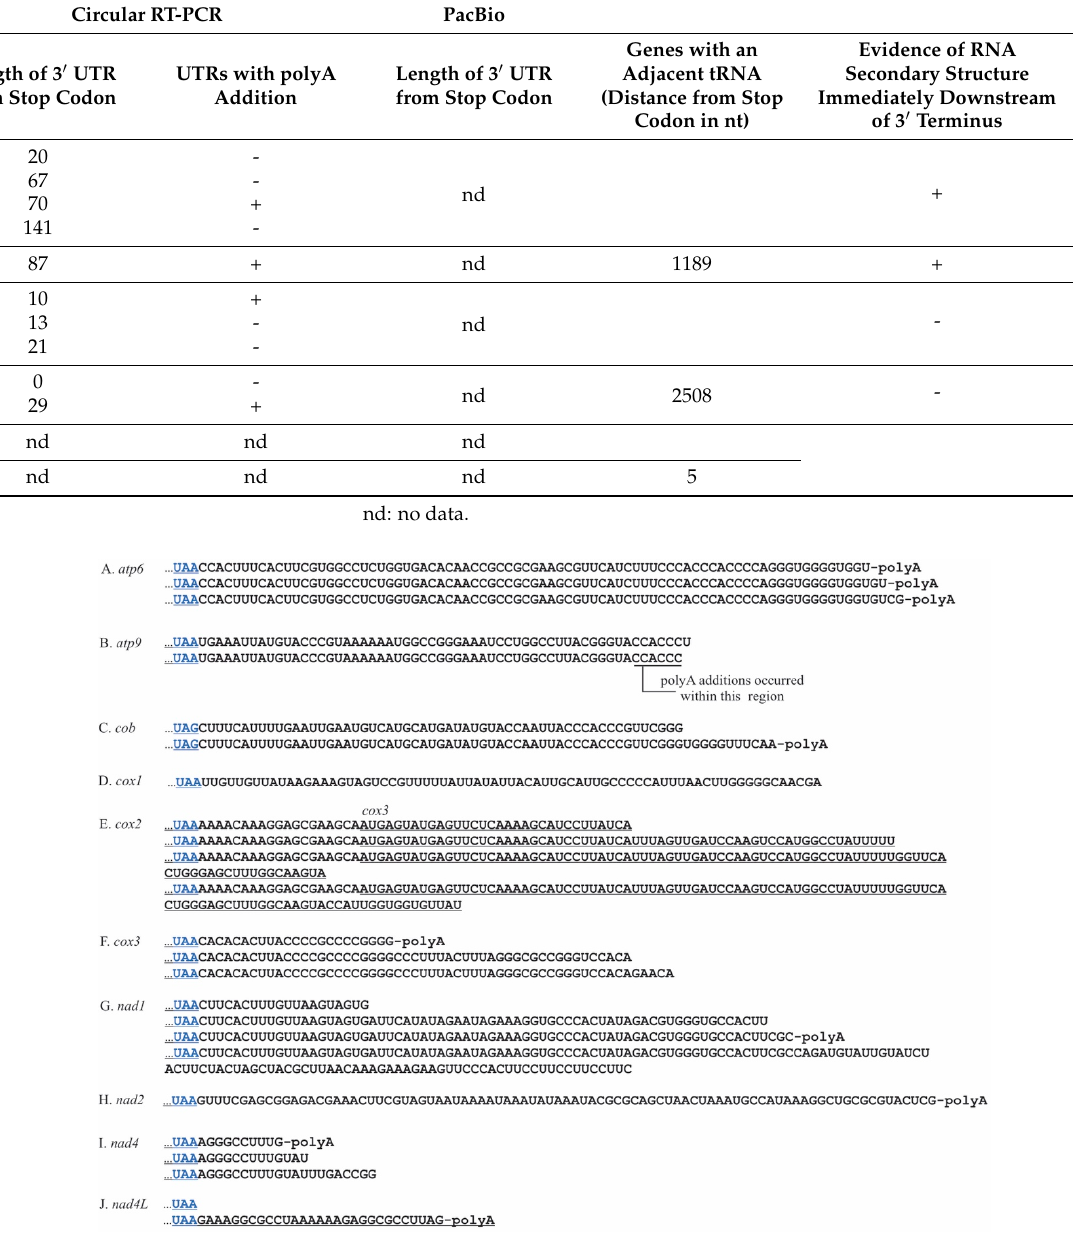
Figure 6. The 3 ′ termini and UTRs of ten C. vulgaris mitochondrial mRNAs. Stop codons are blue. ( A ). Three termini were detected for atp6 , a portion of each had a poly(A) addition. ( B ). Several termini were detected for atp9 . The longer one (upper) had no oligonucleotide additions, while those lacking the terminal uracil had poly(A) additions within a 6 nt region. ( C ). Two cob termini were detected and the shorter one had no detectable oligonucleotide additions while the longer (lower) one did. ( D ). A single terminus was detected for cob with no oligonucleotide additions. ( E ). Four termini were detected for cox2 . All had a portion of the adjacent cox3 gene and no oligonucleotide additions. ( F ). Three cox3 termini were detected. A portion of the shortest UTR had poly(A) tails, while the two longer ones did not. ( G ). Four termini were detected for nad1 but only one had a poly(A) tail. ( H ). A single terminus was detected for nad2 and a portion of them had a poly(A) tail. ( I ). Three termini were detected for nad4 and a portion of the shortest had a poly(A) tail. ( J ). Two termini were detected for nad4L . One occurred directly adjacent to the stop codon. A portion of the longer UTR had a poly(A) addition.